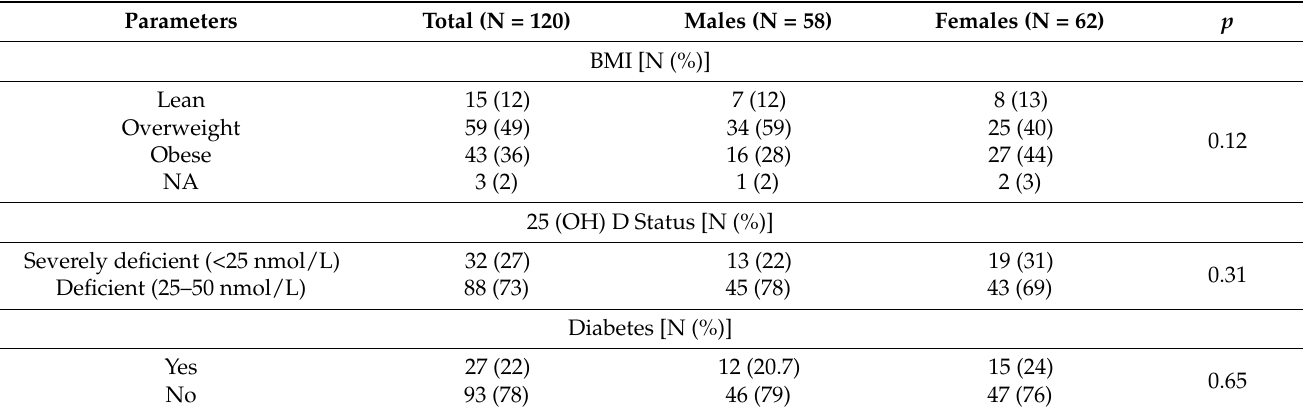
Table 1. Baseline characteristics of study participants [N